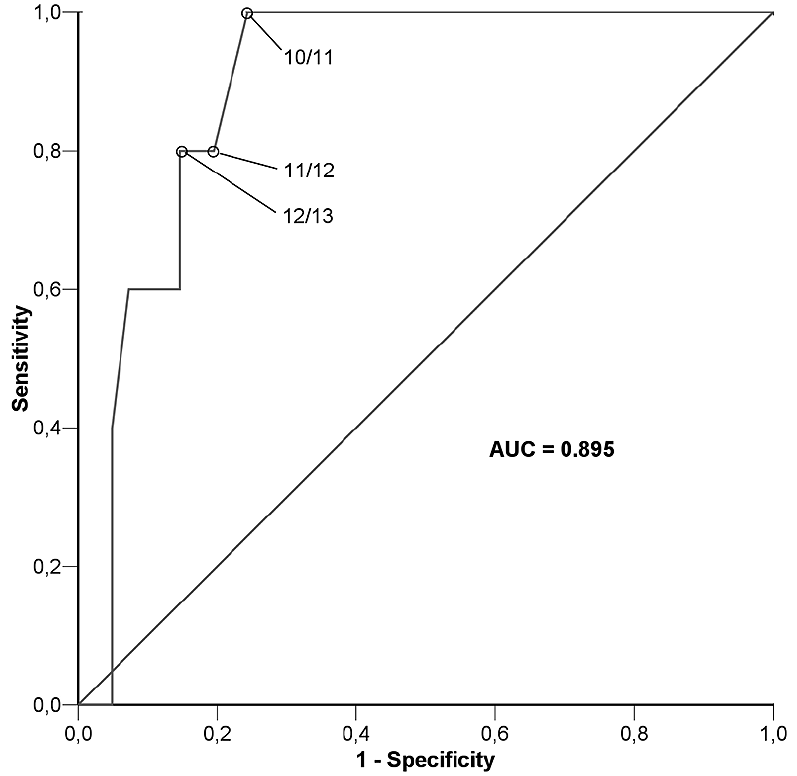
Fig. 2. Receiver operating characteristics (ROC) curve for the GDS. AUC = Area Under